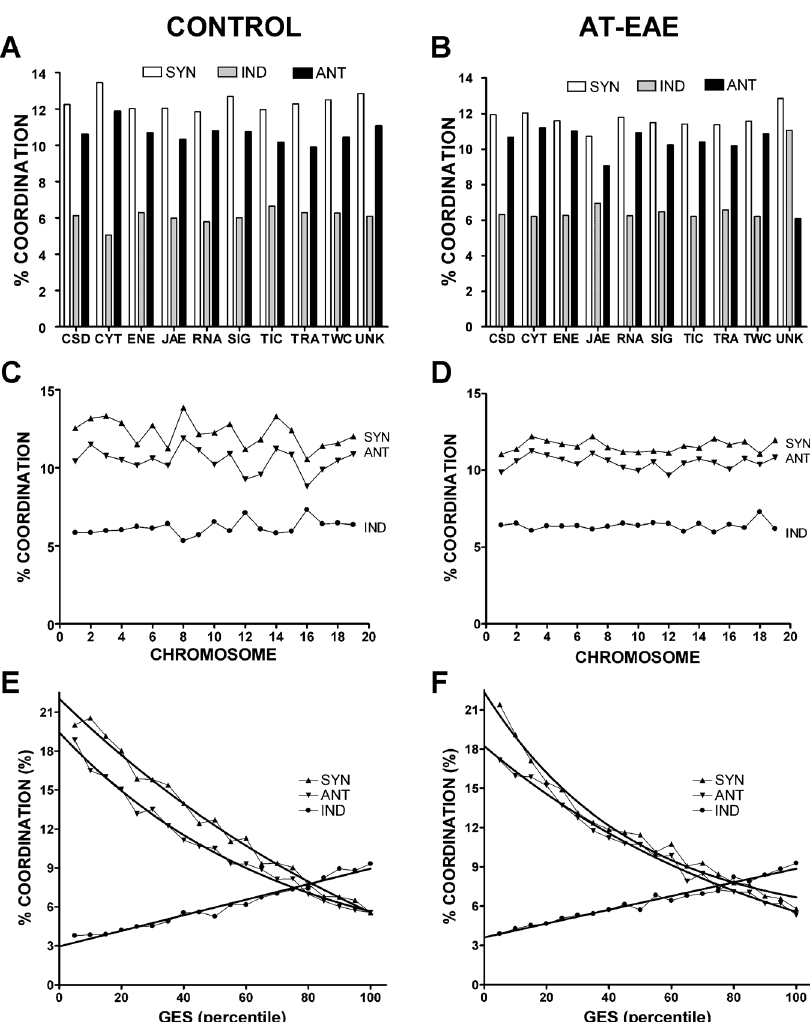
Figure 4. Average percentages of synergistically (Syn), antagonistically (Ant), and independently (Ind) expressed gene pairs in functional categories (A and B), chromosomes (C and D) and GES percentiles for control (A, C, E) and AT-EAE (B, D, F) spinal cords. Note the quasi-uniform distributions of the percentages in functional categories and chromosomal locations in both conditions, the not-significant alteration of the percentages in AT-EAE mice and the inverse exponential relationship between synergistic and antagonistic coordination and expression stability (GES